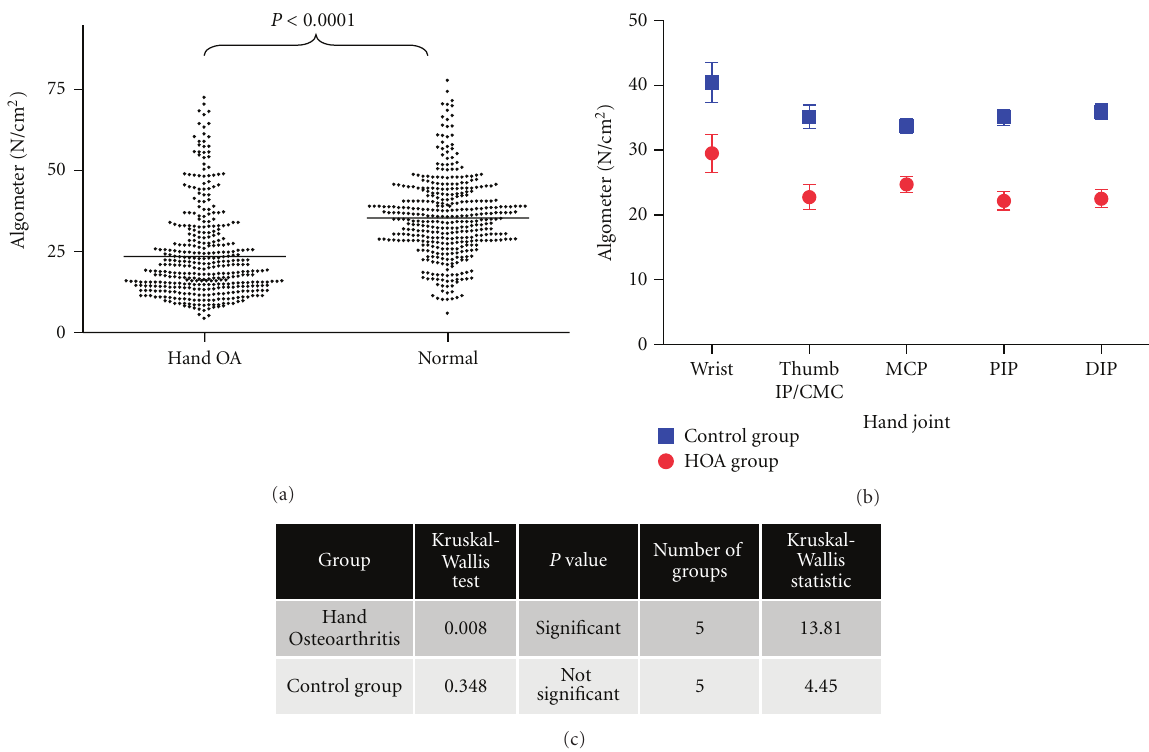
Figure 2: Pain threshold analysis in hand OA and control group. (a) Plot of algometer scores in Newtons per square cm (N/cm 2 ) for a total of 780 joints in the hand OA participants and controls is shown. Each point represents one hand joint region algometer score with mean values indicated by the solid line. (b) Subgroup analysis of data in hand OA and control groups stratified according to joint region involved. The 5 subgroups include wrist, thumb 1st CMC/IP, MCPs, PIPs, and DIPs. Data plotted are mean ± SEM. SEM was used to account for the varying number of joints between di ff erent groups (c). Statistical comparison between groups is shown in (b). The Kruskal-Wallis test was used to evaluate statistical significance between the subgroups within the hand OA and control groups. A significant di ff erence between groups was considered at P ≤ 0 . 05.